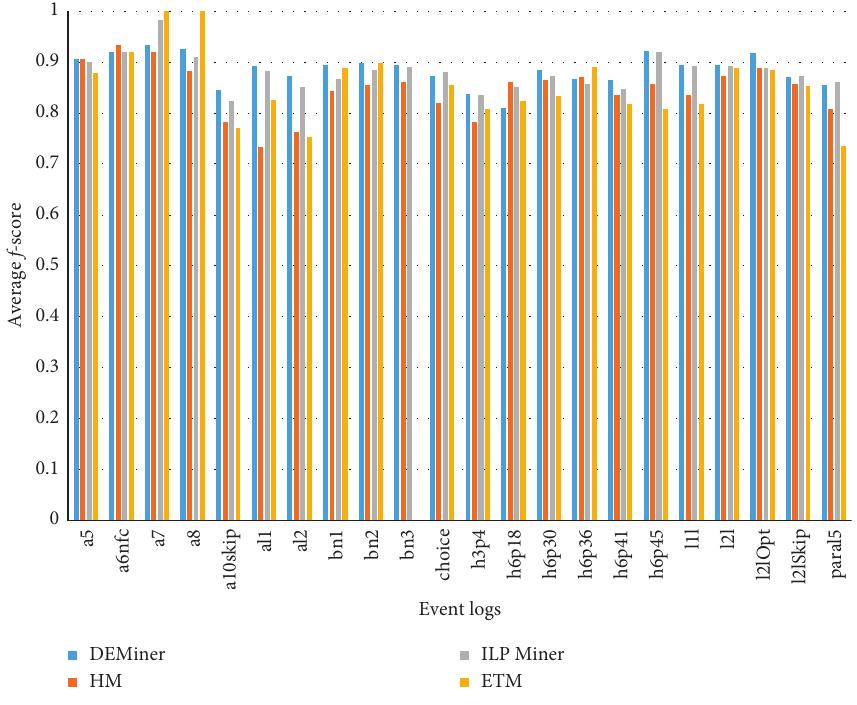
Figure 8: The average f -score of four algorithms on 22 event logs with 10% noise.